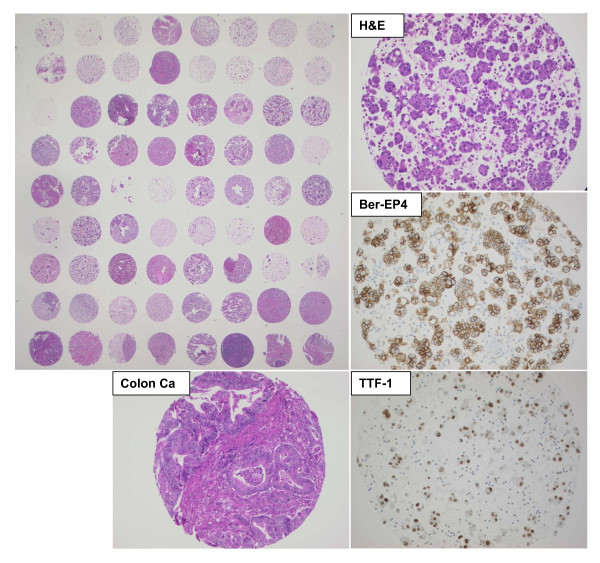
Whole section view of first hybrid C/TMA and representative core from cytologic cell block of a lung adenocarcinoma, stained with H&E, Ber-EP4 and TTF-1. Lower left: control histologic core of a colon adenocarcinoma. Compare cellular density and thickness of tissue between cytologic and histologic core.